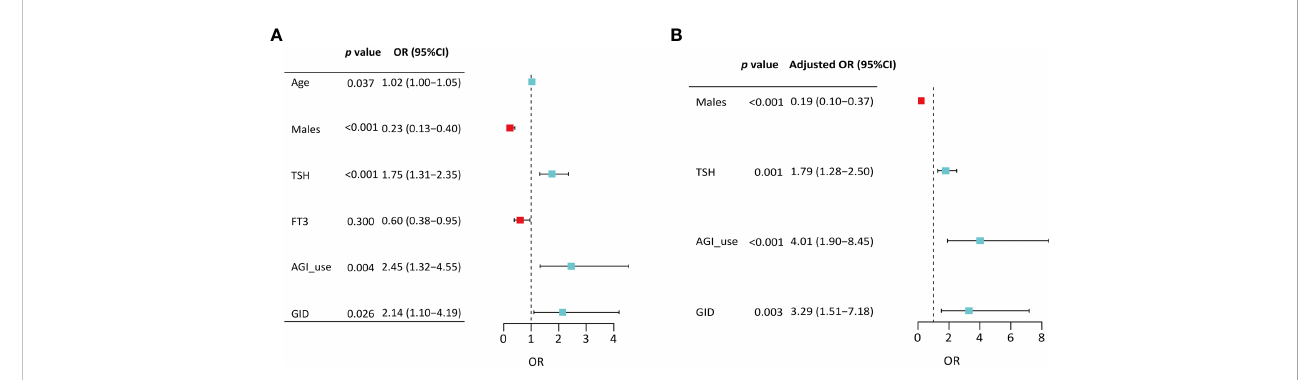
FIGURE 1 Binary logistic regression analyses of variables associated with gastrointestinal side effects among patients treated with liraglutide. (A) Model from all signi fi cant variables in univariate analyses; (B) Final model from after sequentially removing variables with the nonsigni fi cant P value. TSH, thyroid stimulating hormone; FT3, free triiodothyronine; AGI, a -glucosidase inhibitor; GID, gastrointestinal disease.